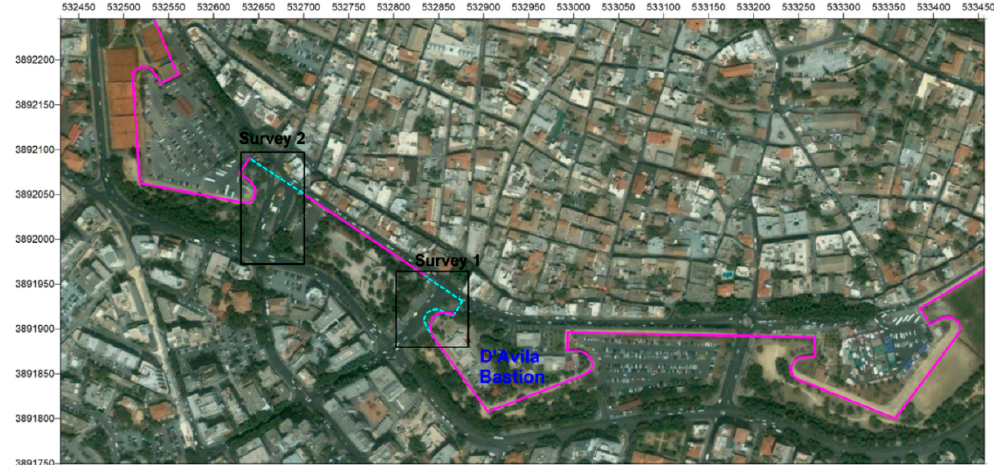
Figure 5. Google Earth ™ satellite images (2008) with the indication of gaps in Venetian wall (in blue) research subjects of Surveys 1 and 2.